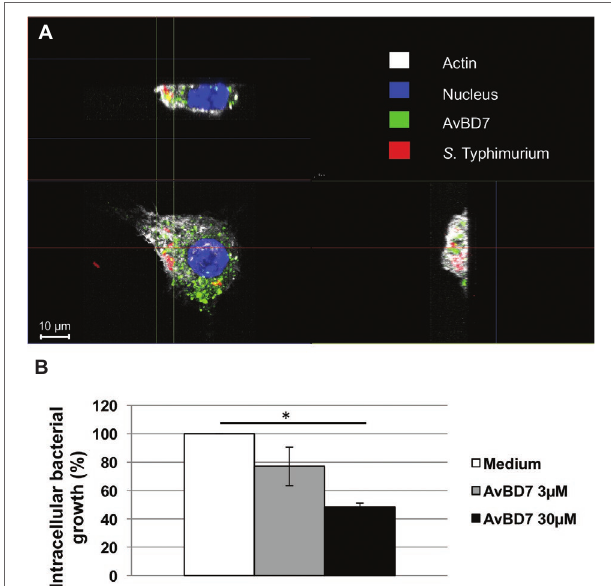
FIGURE 4 | Interaction of AvBD7 with murine macrophages infected by S. Typhimurium. 3D confocal microscopy analysis gave the representative image (A) of RAW 264.7 macrophage infected by S. Typhimurium DT104 strain (red) and incubated with labeled AvBD7 (green). The image shows horizontal (bottom left) and vertical (top left and bottom right) sections of the cell processed for immunofluorescence. Nucleus is in blue and actin in white. Intracellular multiplication of bacteria (B) in RAW 264.7 macrophages infected by S. Typhimurium and treated or not by AvBD7. Cells were incubated with bacteria for 1 h at MOI of 10, treated with gentamicin (100 μg/ml) for 1 h, and incubated for 24 h in the absence (medium; white bar) or presence of 3 μM (grey bar) or 30 μM (black bar) of AvBD7. Results are expressed as mean percent ± standard error of the mean (each well/condition in triplicate; n = 3); Asterisk indicates significant difference with the non-treated cells ( p =